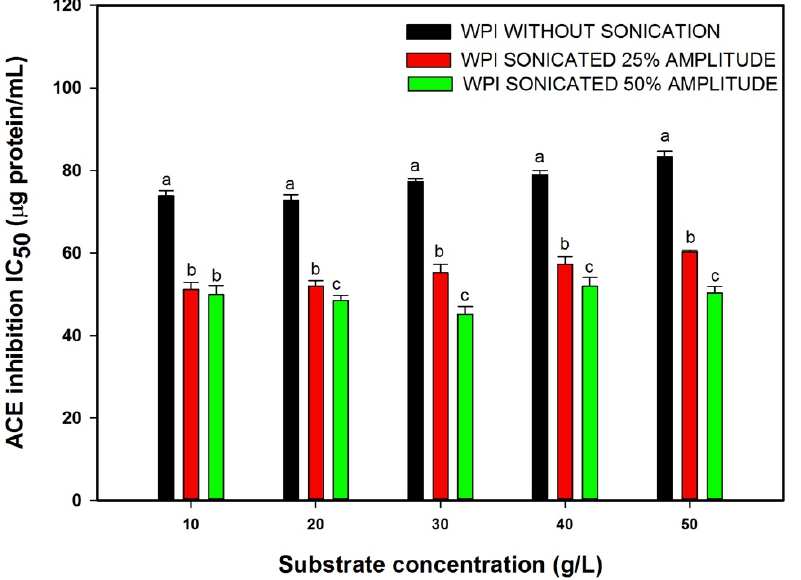
Figure 1. Effect of substrate concentration and ultrasonic treatment on the angiotensin-converting enzyme (ACE) inhibitory activity of whey protein isolate (WPI) hydrolysates. Values are means with their standard deviations depicted by vertical bars. Different letters indicate significant differences ( α = 0.05, Dunnett’s test) within the same group.